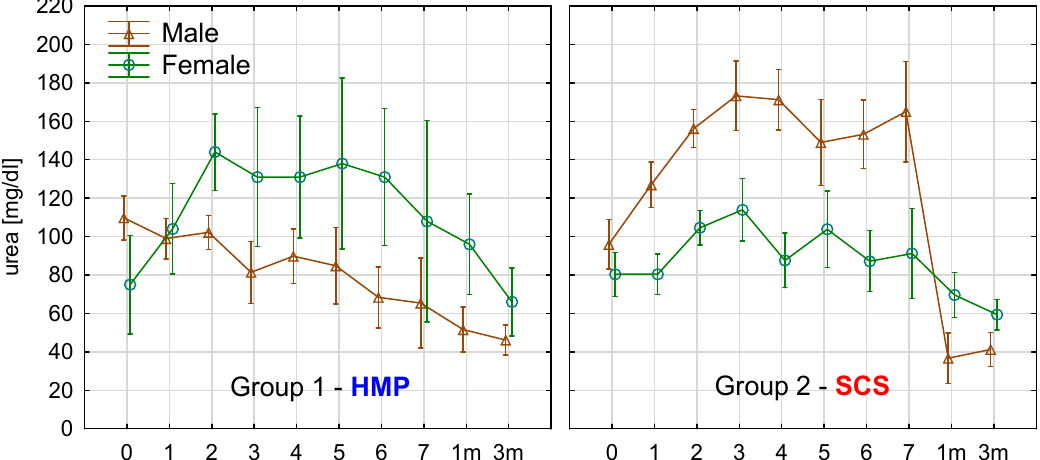
Figure 9. Urea concentration repeated measures with recipient gender and study groups (rANOVA, p = 0.02138 , n = 66).